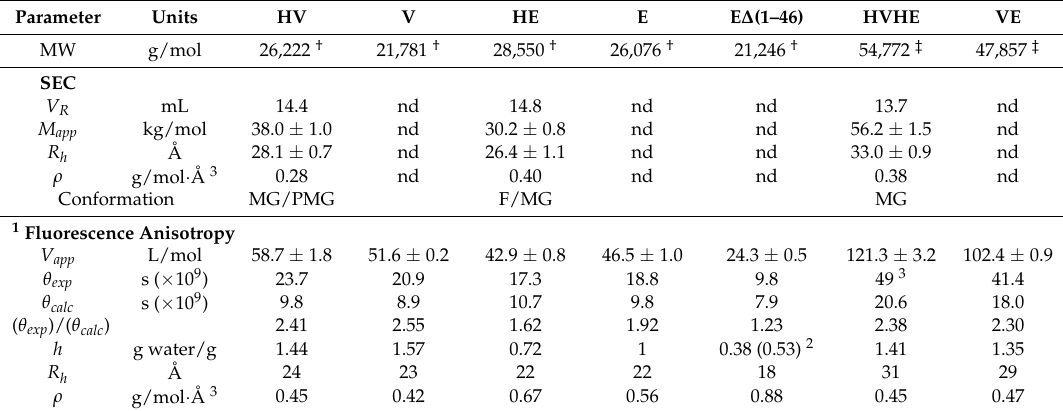
Table 1. Physical parameters of the various molecular forms of VPg, eIF4E and of their binary complexes.